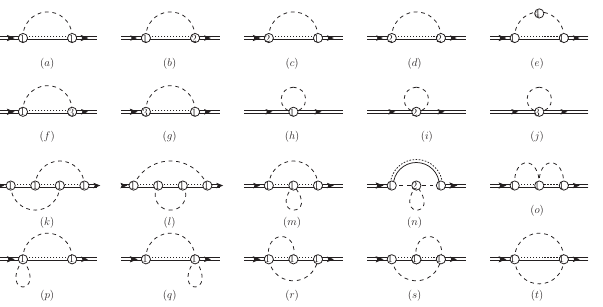
Figure 12. One and two-loop self-energy diagrams contributing to the width of the delta resonance up-to-and-including fifth or- der according to the standard power counting. The dashed and double solid lines represent the pions and the delta resonances, respectively. The double (solid-dotted) lines in the loops corre- spond to either nucleons or deltas. The numbers in the circles give the chiral orders of the vertices. Figure from [79].